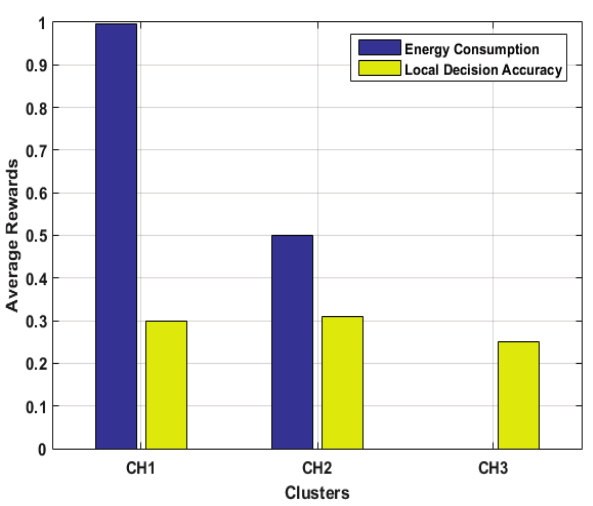
Figure 10. Average cumulative rewards for clusters.